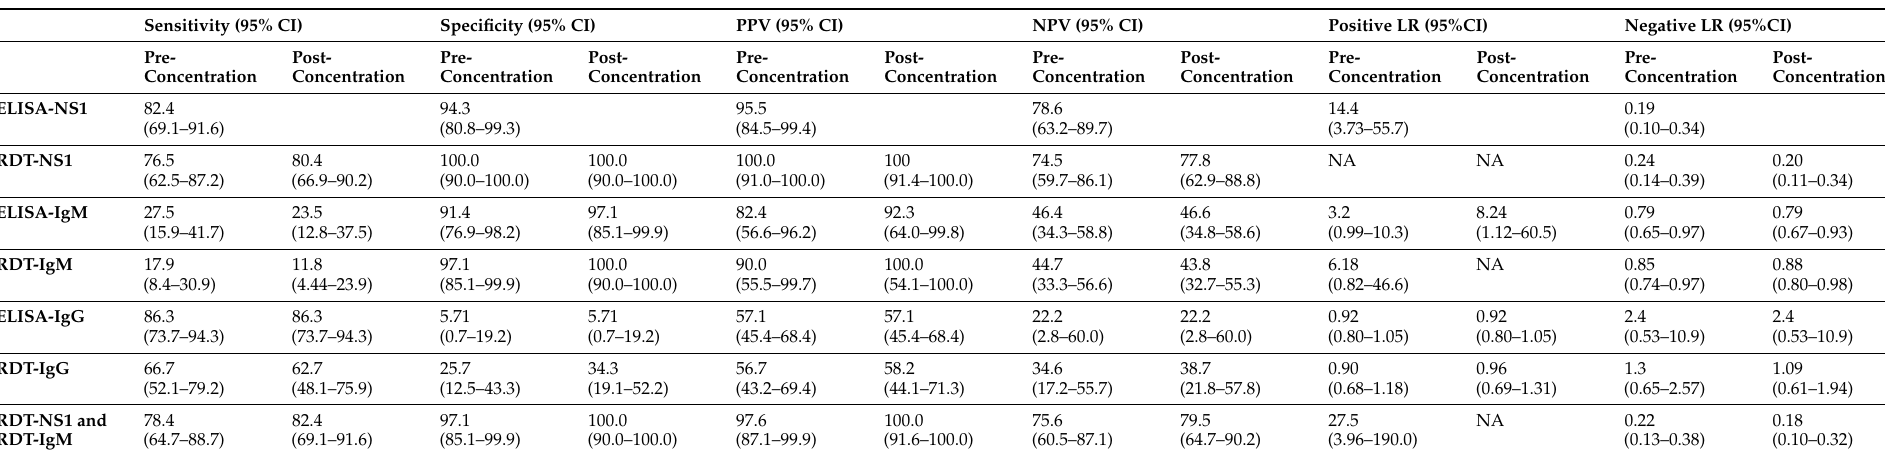
Table 2. Summary of diagnostic performance of different techniques (N =